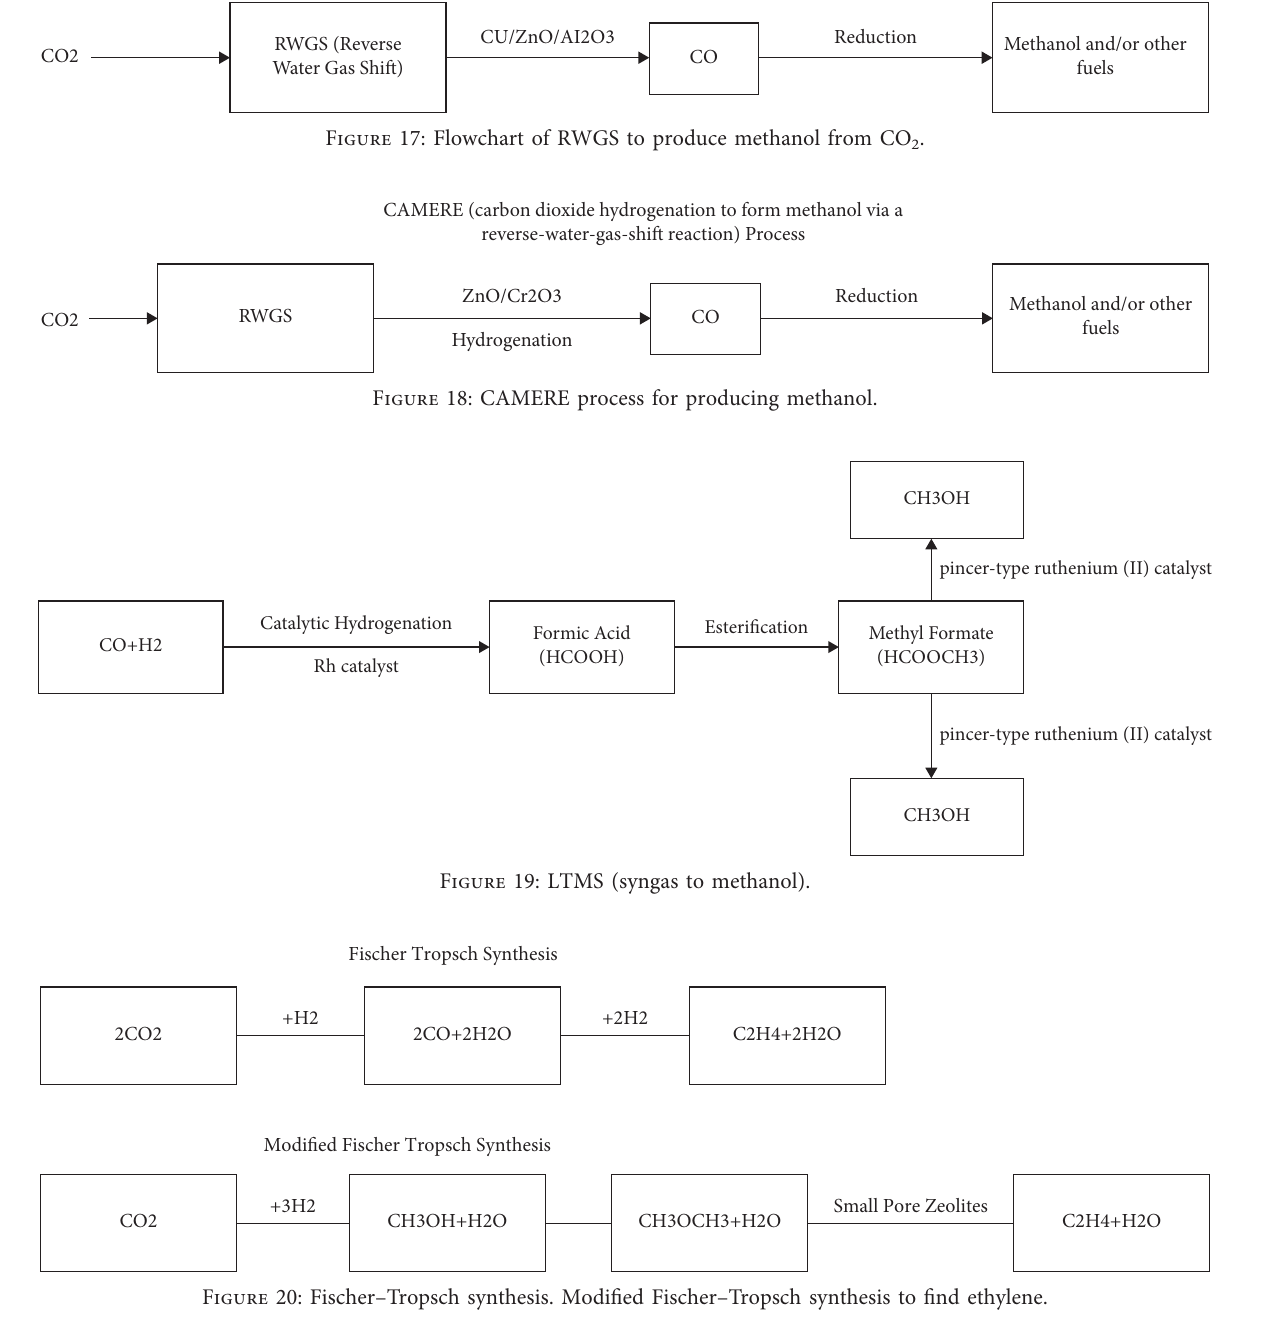
Figure 20: Fischer–Tropsch synthesis. Modified Fischer–Tropsch synthesis to find ethylene.